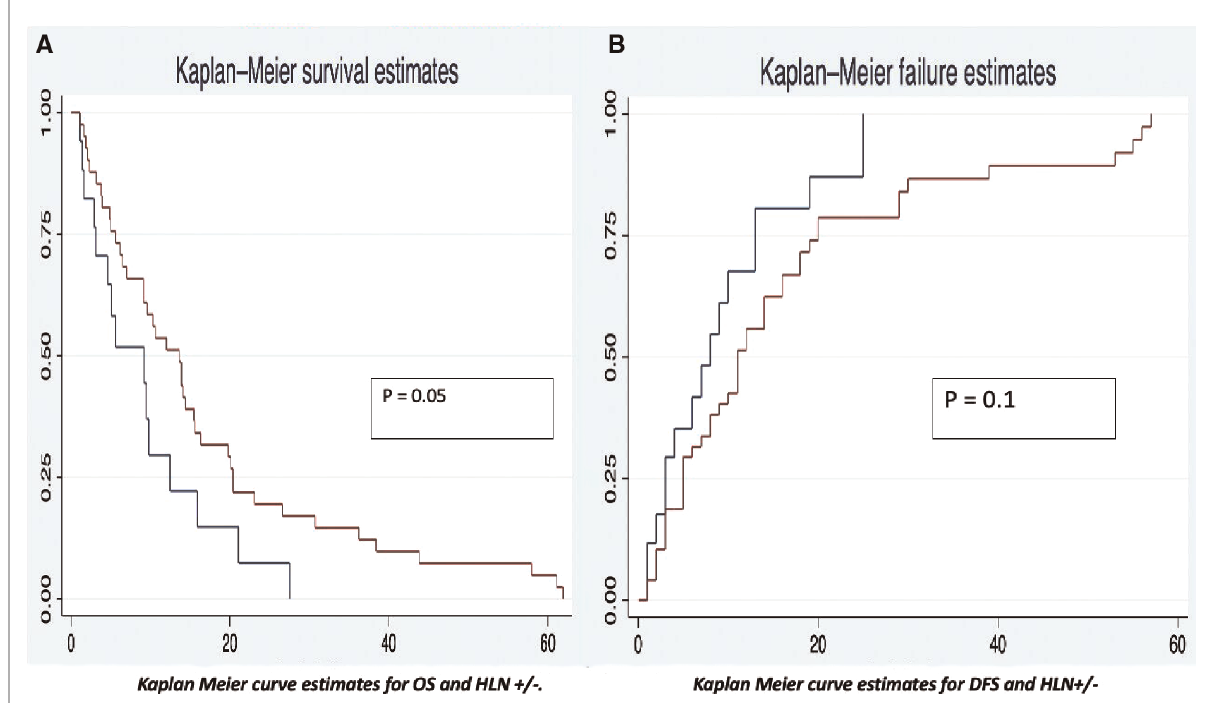
FIGURE 2 Kaplan meier curve estimates for OS and DFS (HLN +/ −